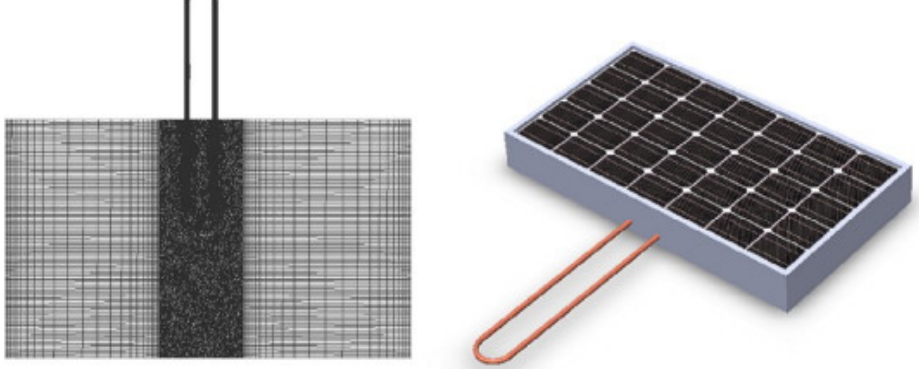
Figure 47. Model of a PV panel with a heat pipe [186].